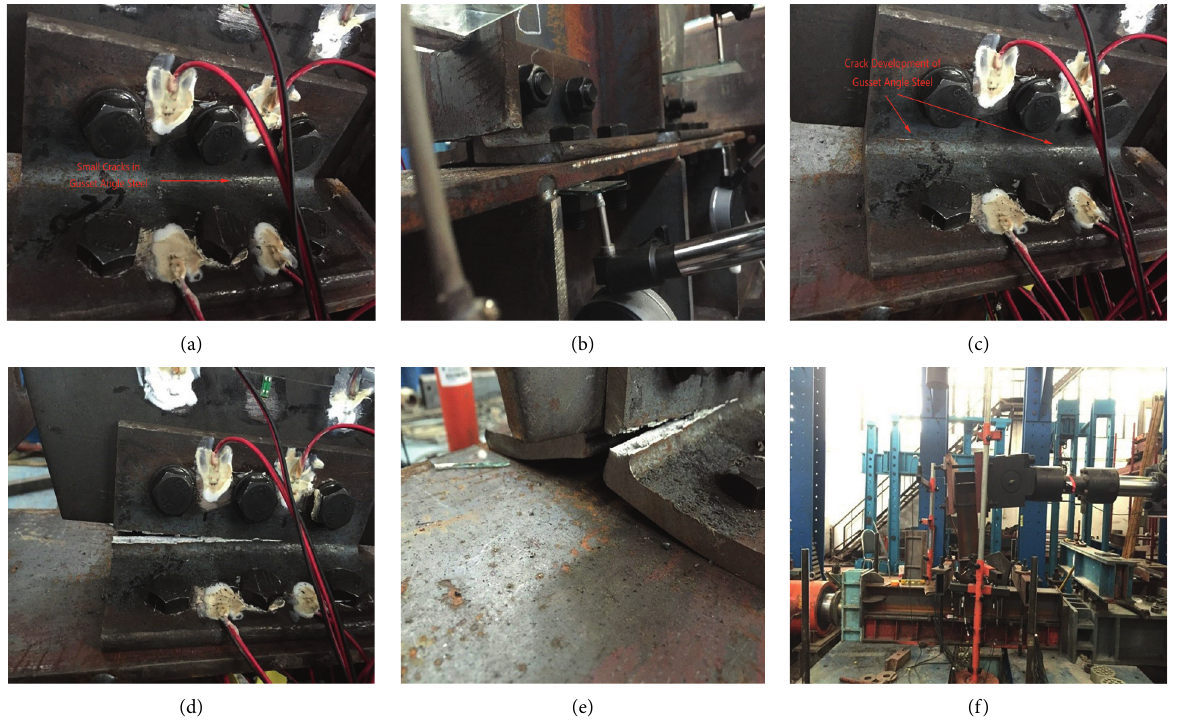
Figure 6: Failure mode of SJB-2. (a) Small cracks in gusset angle steel (30mm). (b) Gap between web angle steel and column flange ( − 30mm). (c) Crack development of gusset angle steel (45 mm). (d) Fracture failure of upper angle steel (60 mm). (e) Gusset angle steel warping on one side (60mm). (f) Joint loading